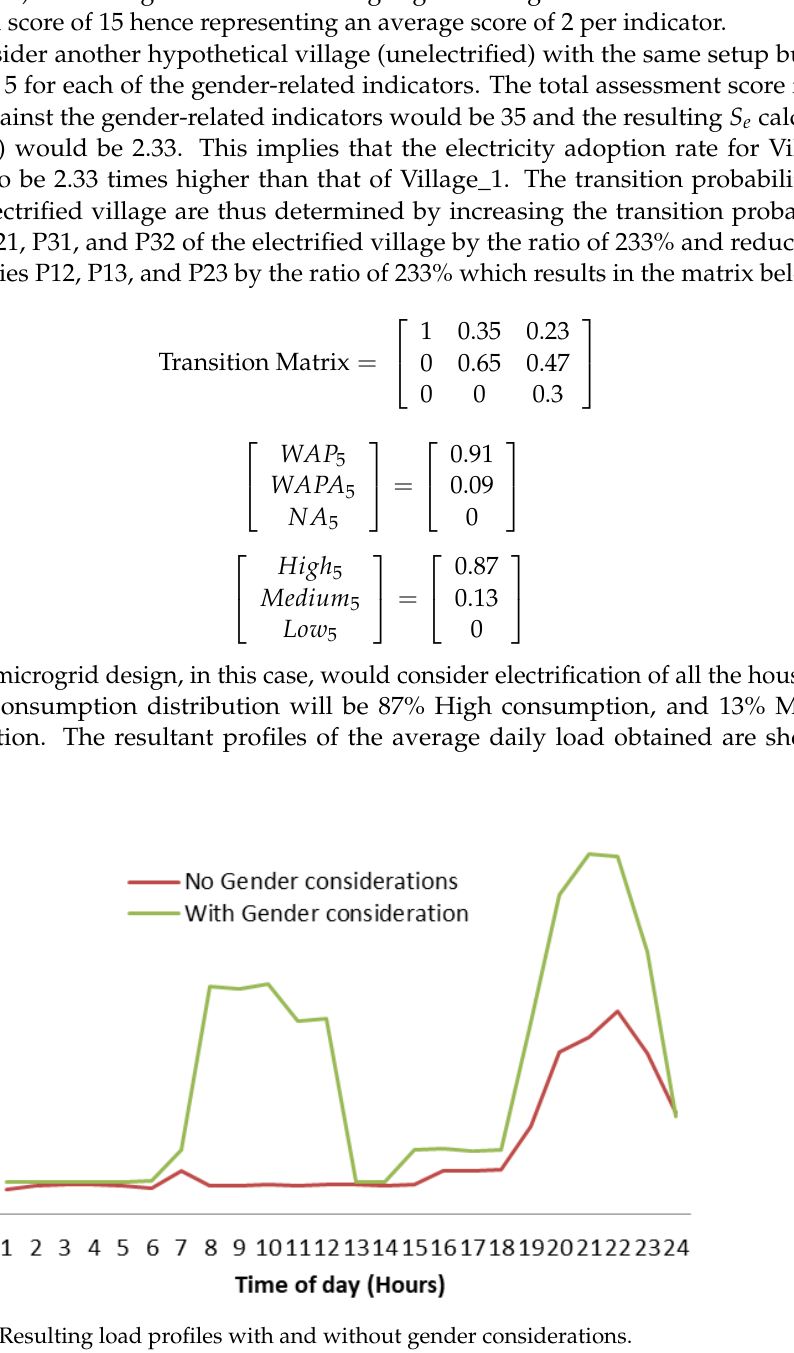
Figure 16. Resulting load profiles with and without gender